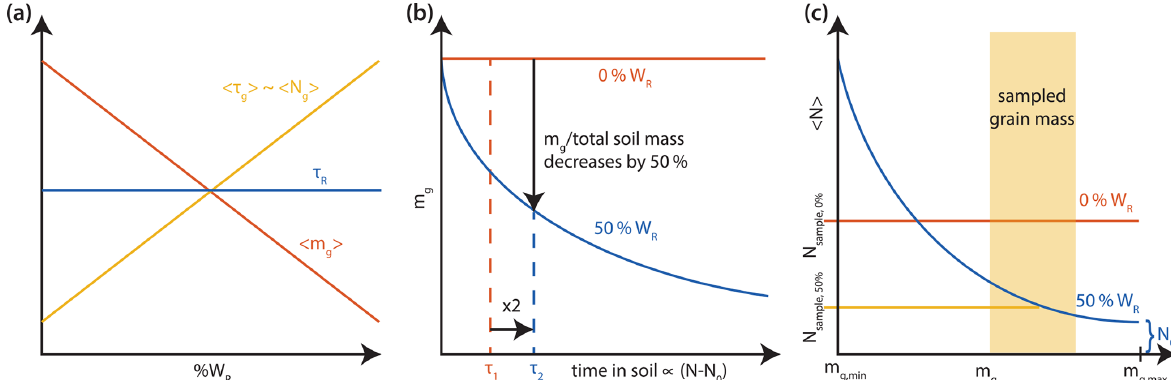
Figure 4. Conceptual plots showing the effects of regolith weathering on a homogeneous soluble bedrock for weathering proportional to grain mass. (a) The average grain mass in the regolith (cid:104) m g (cid:105) will decrease with increasing percentage of weathering W R if all other variables are fixed, while the average grain residence time (cid:104) τ g (cid:105) and therefore grain CRN concentration would increase. However, the average residence time of regolith mass (cid:104) τ R (cid:105) will remain constant. (b) In the absence of weathering, no relationship is predicted between the grain mass and regolith residence time. Weathering will introduce such a relationship and lead to a decrease in grain size with time (blue line). If regolith weathering constitutes 50% of the denudation, the residence time of a grain will double compared to the no-weathering case; however, the grain will also contribute 50% less to the total regolith mass. Therefore, no net difference in the average CRN concentration of the regolith occurs. (c) A CRN sample collected within a certain grain size range can be biased due to weathering. In the case of regolith weathering, larger grain sizes will, on average, have a lower CRN concentration, that is, at minimum, the nuclide concentration entering the regolith N 0 . Sampling the full regolith grain size range would result in the same CRN concentration compared to the no-weathering case. However, a sample from the coarser end of the grain size range (yellow box) would result in a too low CRN